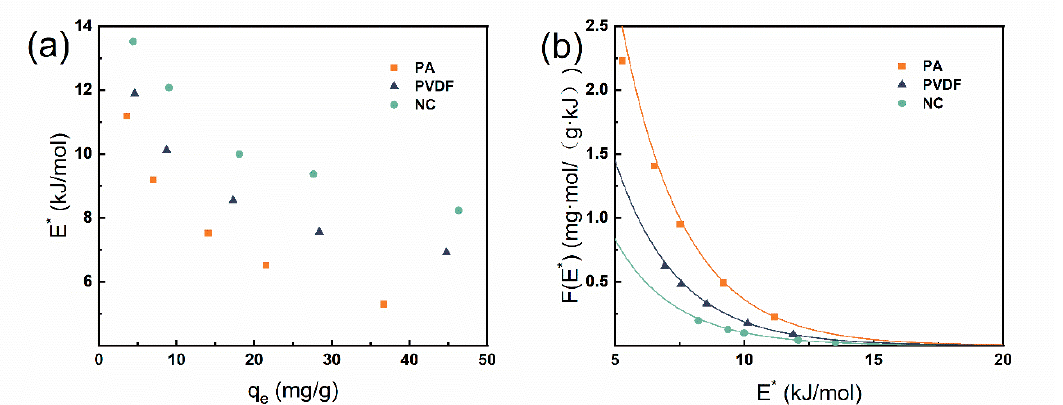
Figure 4. Site energy distribution of BPA adsorption by different MFMs: Adsorption energy vs. adsorption amount ( a ) and frequency distribution vs. adsorption energy ( b ).